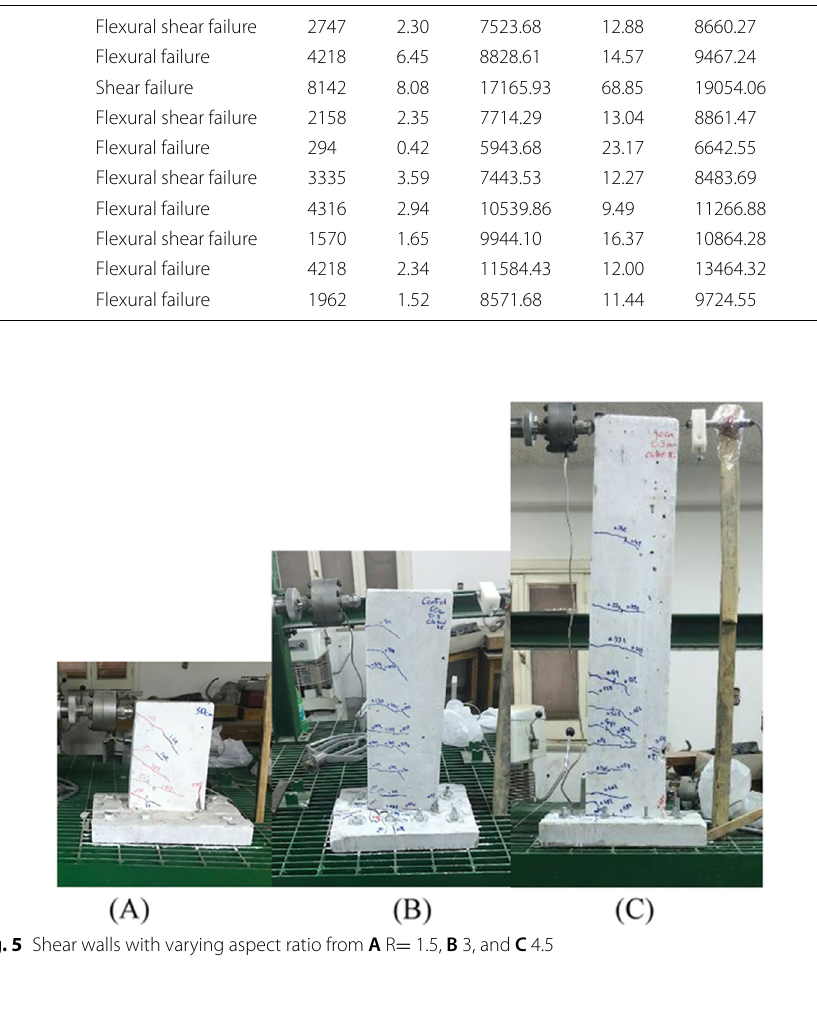
Table 2 Summary of the shear wall specimens test results Specimen